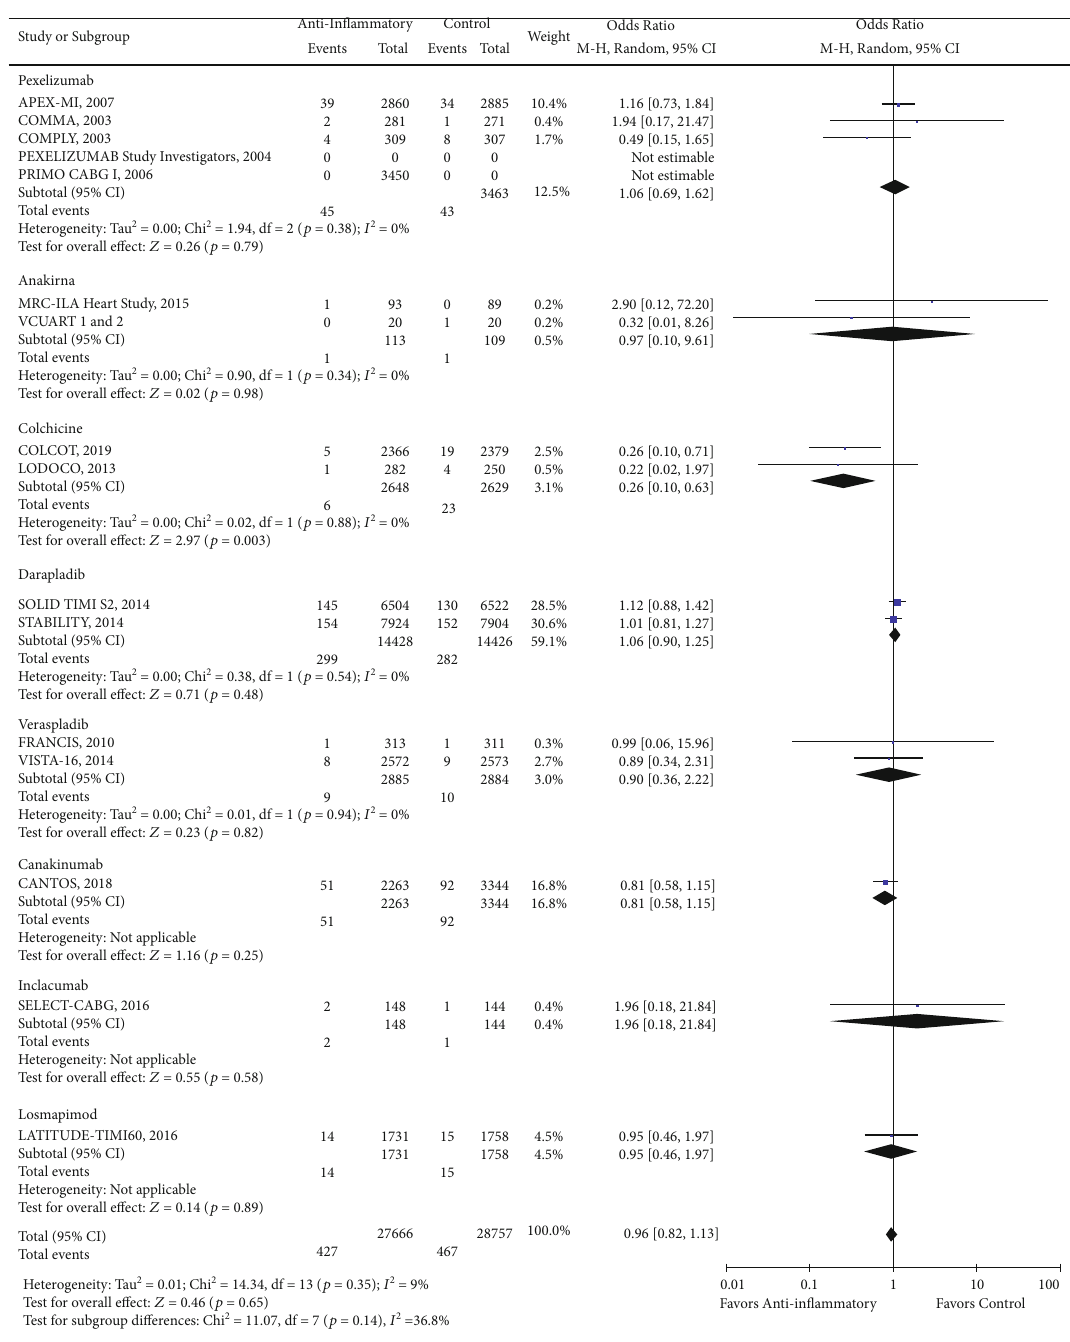
Figure 5: Forest plot of stroke. There was no signi fi cant di ff erence between anti-in fl ammatory therapy and standard therapy alone in regard to stroke (OR 0.96, CI 0.82-1.13; P = 0 : 65